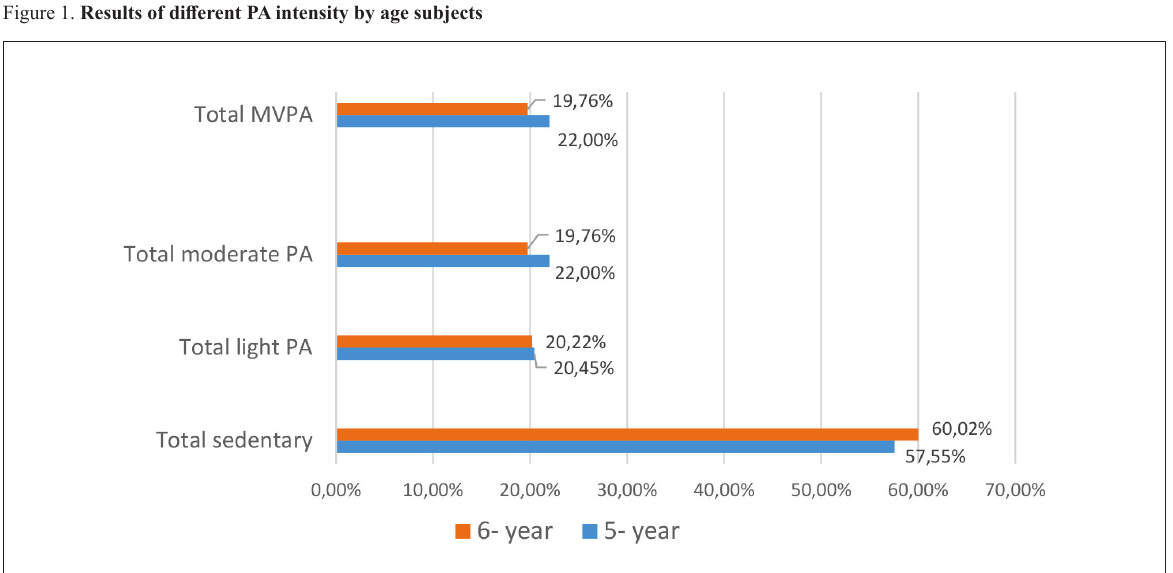
Figure 1. Results of different PA intensity by age subjects